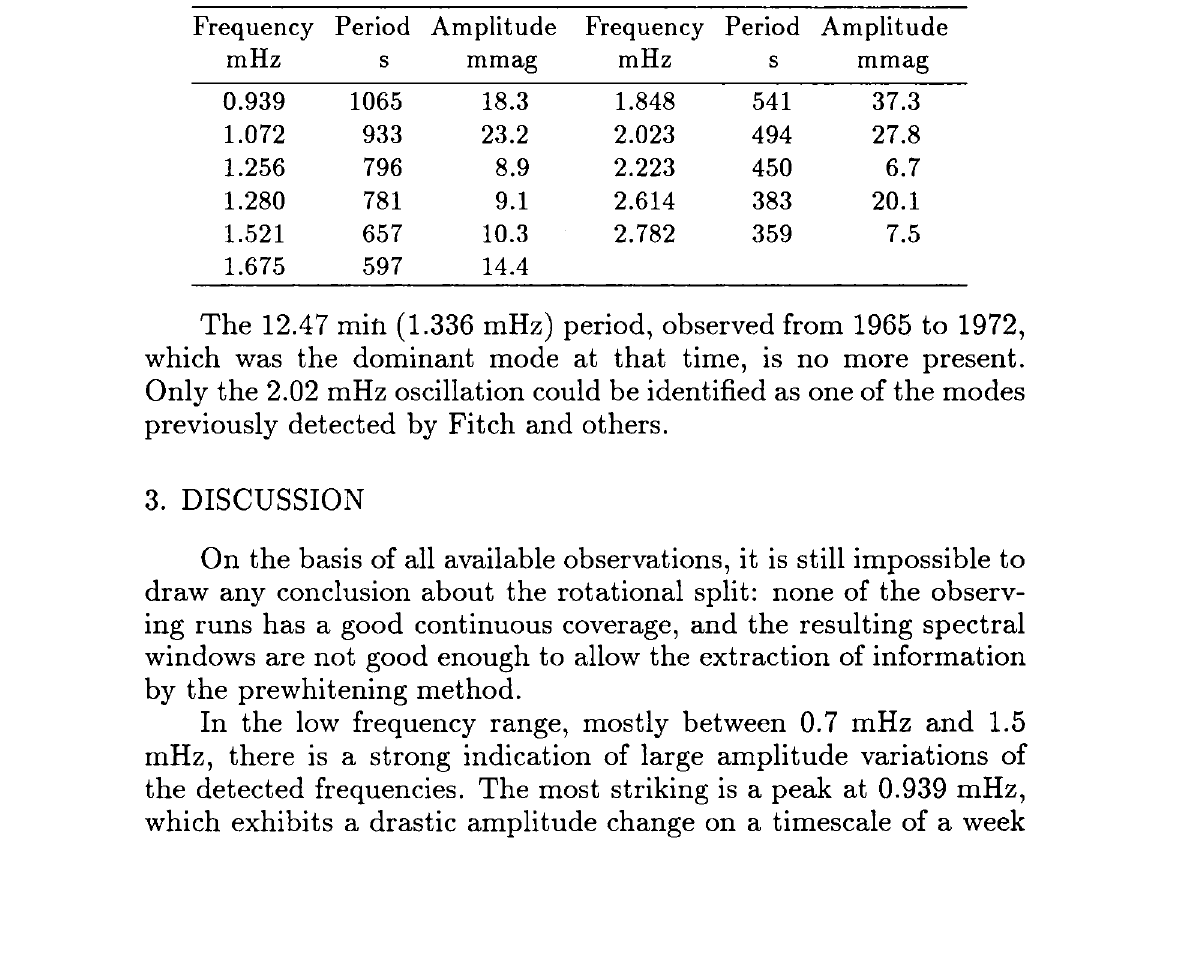
Table 2. Frequencies observed during the WET campaign. Frequency Period Amplitude Frequency Period Amplitude mHz s mmag mHz s